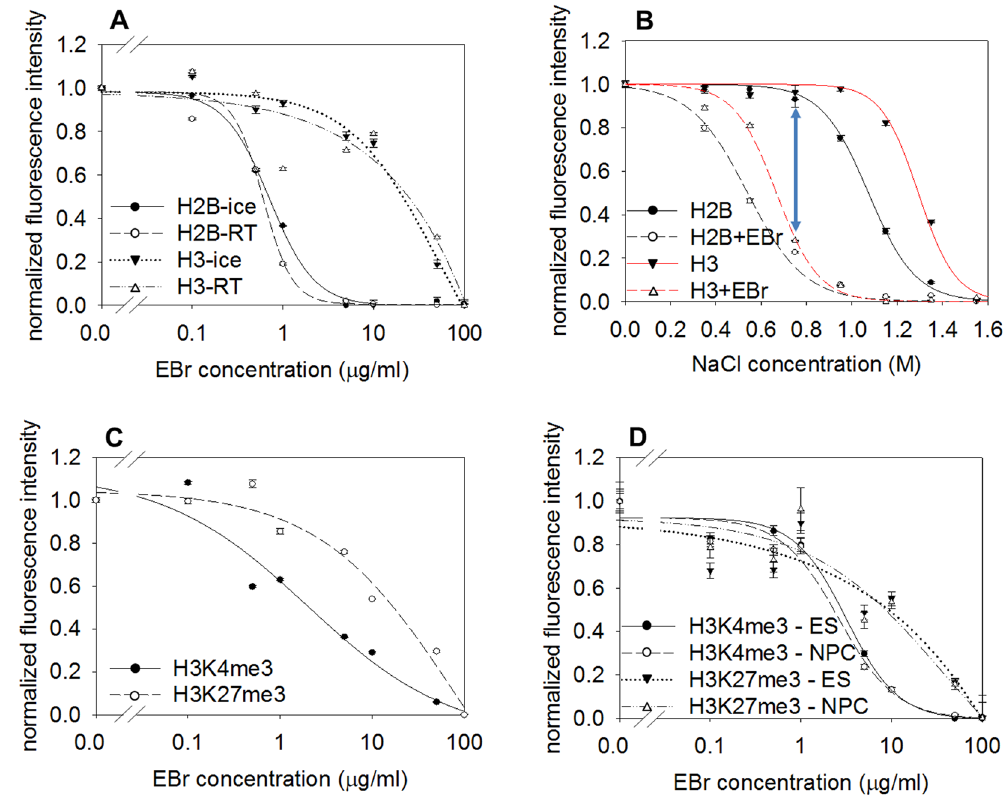
Figure 2. EBr induced nucleosome destabilization. ( A ) EBr induced elution of H2B-GFP and H3-GFP performed on ice and at room temperature (RT) in histone-GFP expressor HeLa nuclei. EBr was applied in the presence of 0.75 M NaCl. ( B ) Effect of co-treatment with EBr and salt in histone-GFP expressor HeLa nuclei. The shift of elution curves in the presence of 100 µ g/ml EBr is seen comparing the continuous and dashed lines. The blue double arrow shows that the maximal effect of EBr on nucleosome stability occurs at 0.75 M salt. ( C ) EBr elution profiles of H3K4me3 or H3K27me3 in HeLa nuclei. (See also: Supplementary Fig. S1F). ( D ) EBr elution profiles of H3K4me3 or H3K27me3 in mES and NPC nuclei. (See also: Supplementary Fig. S2). The concentration of the intercalators are shown in a logarithmic scale in panels A, C and D. The elution curves refer to G1 phase cells gated according to their DNA fluorescence intensity distribution and the error bars represent SEM of ~600 G1 nuclei measured by LSC. The cell-to-cell and sample-to-sample C.V. values of the elution profiles are shown in Supplementary Table